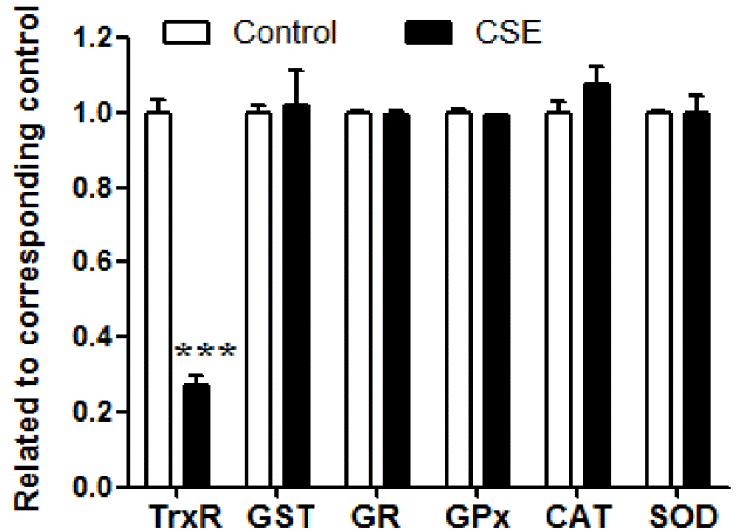
Figure 2. Effects of cigarette smoke extract (CSE) on antioxidant enzyme activities of mouse-liver homogenate. CSE (80 µL) was mixed with mouse-liver homogenate (50 µL) for 20 min at 37 °C. Data are presented as means ± SEM ( n = 3), compared to control, *** p < 0.001. Basal average activities of thioredoxin reductase (TrxR), glutathione S-transferase (GST), glutathione reductase (GR), glutathione peroxidase (GPx), catalase (CAT), and superoxide dismutase (SOD) were 3.2 mU/mg protein, 0.2 U/mg protein, 46.5 U/mg protein, 60.5 mU/mg protein, 19.5 U/mg protein, and 6.3 U/mg protein, respectively.